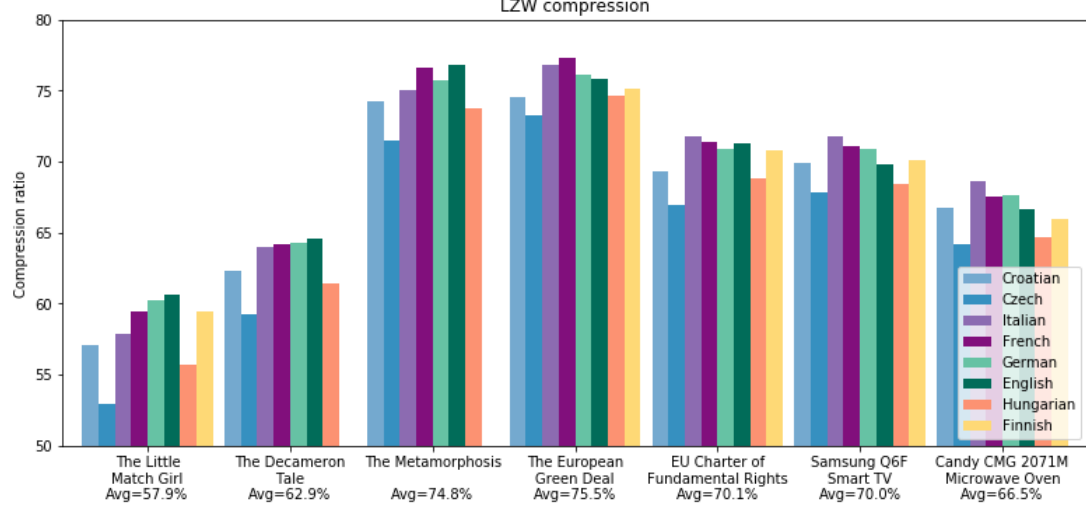
Figure 12. LZW compression